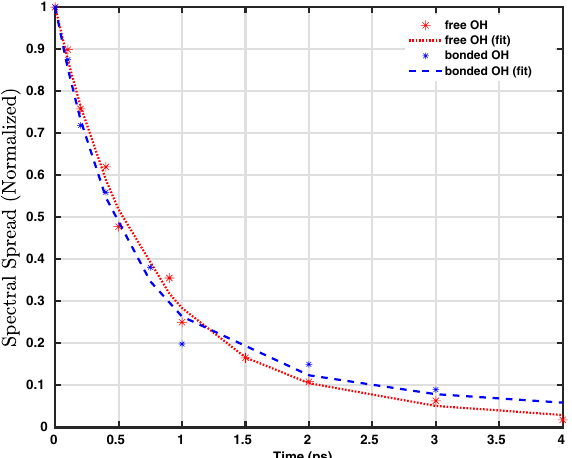
Figure 4. Time-dependent decay of the normalized spectral spread for the free and bonded OH modes of the interfacial molecules. For comparison, the biexponential fit is also